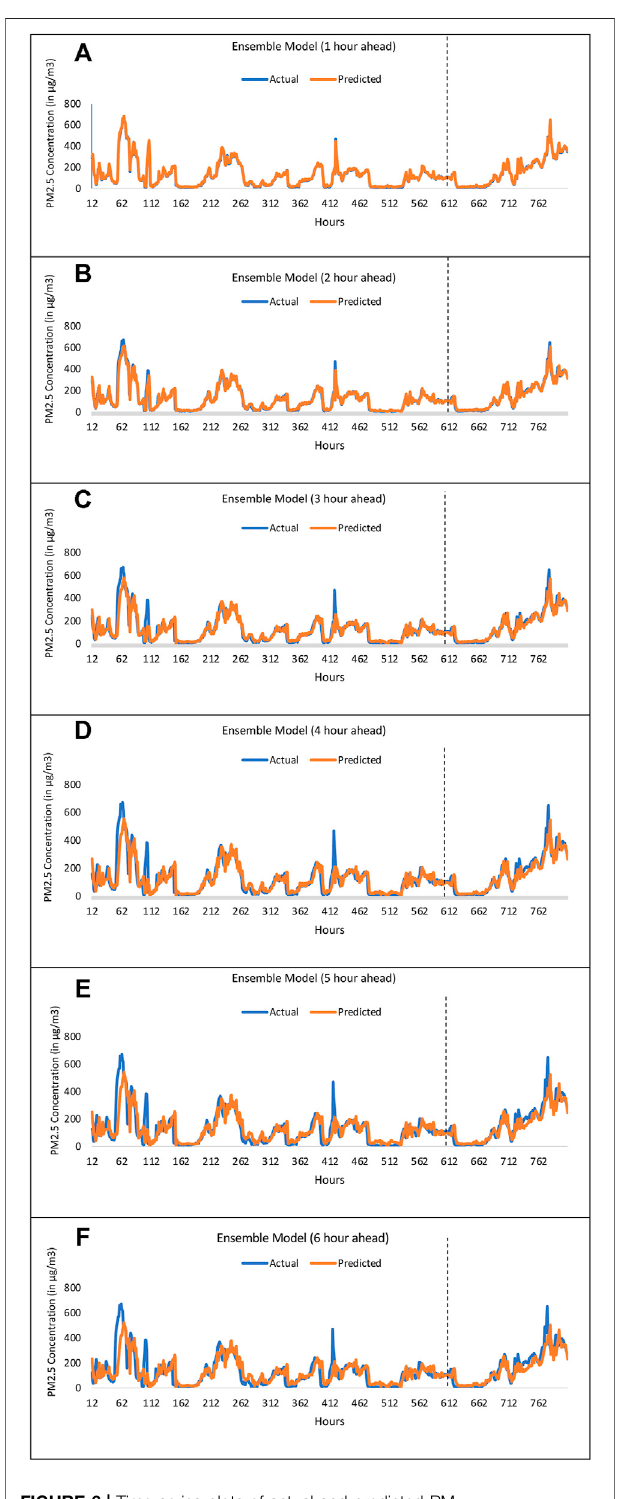
FIGURE 6 | Time-series plots of actual and predicted PM 2.5 concentrations obtained by the ensemble model for (A) 1 h ahead (B) 2 h ahead (C) 3 h ahead (D) 4 h ahead (E) 5 h ahead, and (F) 6 h ahead.